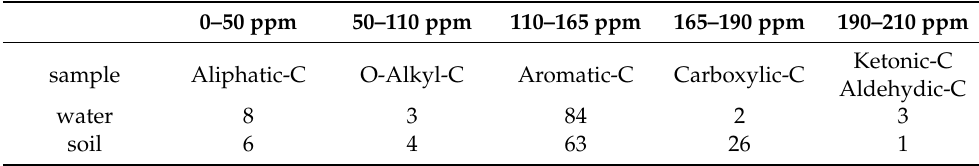
Table 4. Carbon distribution (%) estimated from the integration of 13 C{ 1 H} NMR spectra [38].